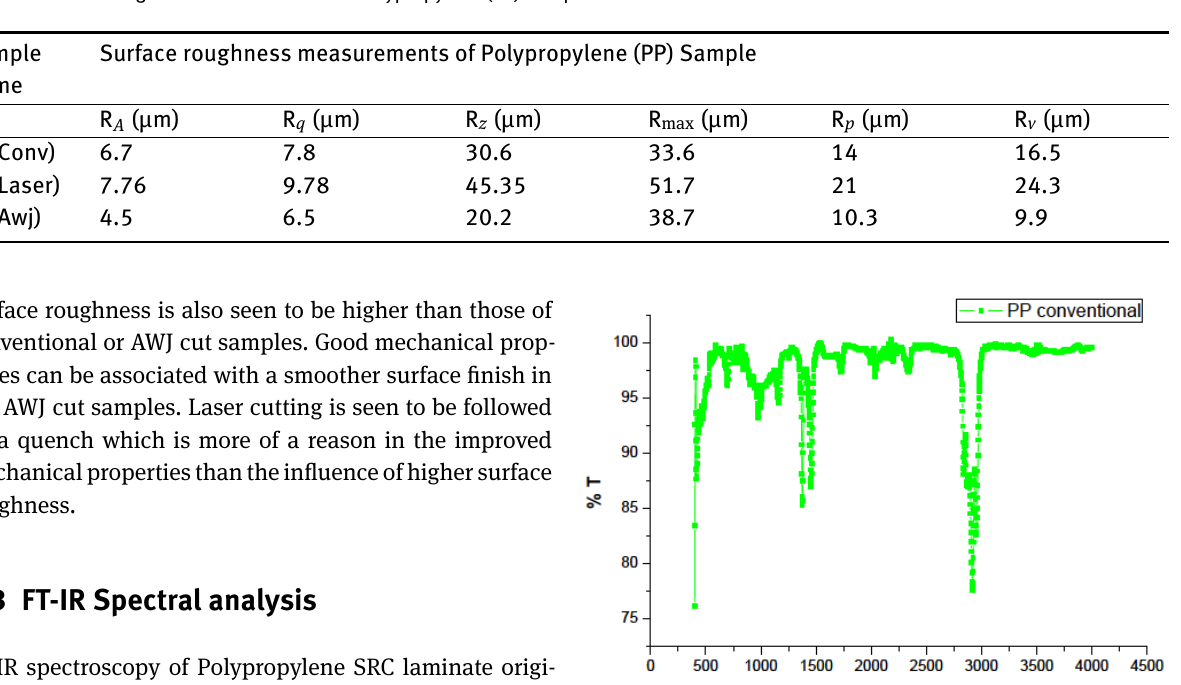
Table 2: Surface roughness measurements of Polypropylene (PP) Sample